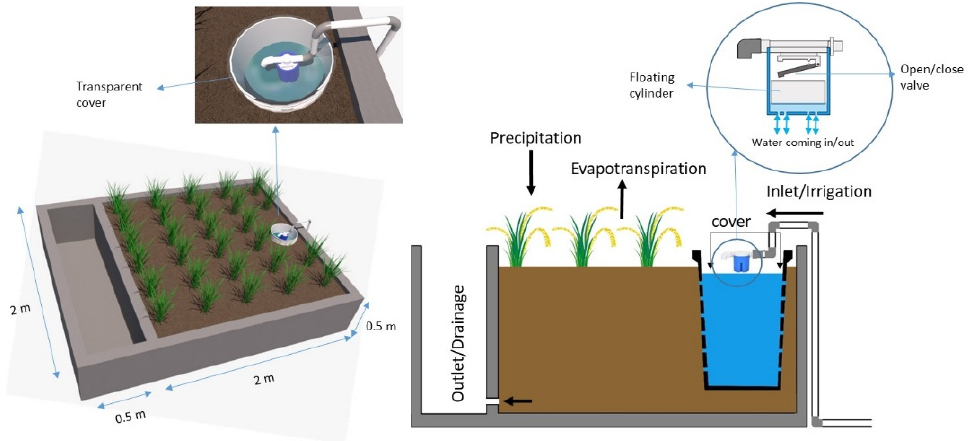
Figure 1. A miniature paddy field equipped with a simple automatic valve.